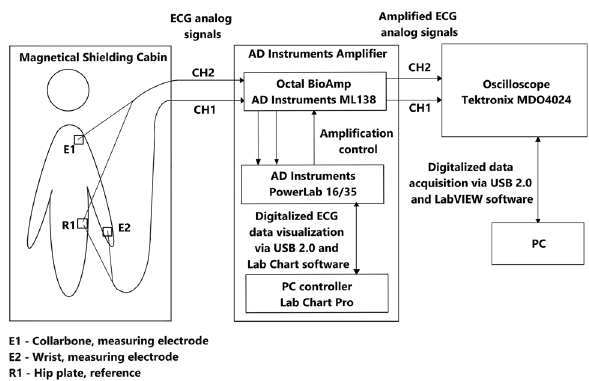
Figure 1. Measuring system for ECG signal propagation